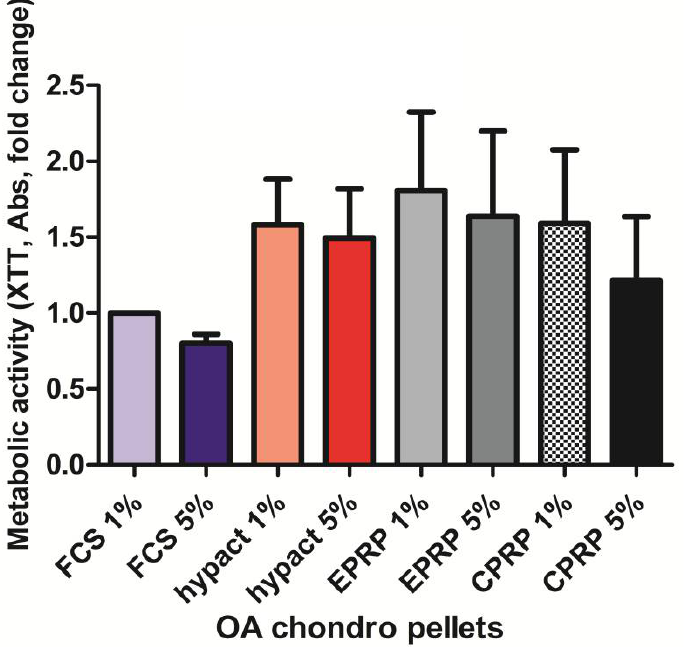
Figure 1. Metabolic activity of OA chondrocytes in 3D pellet culture, n = 5 (CPRP = citrate platelet-rich plasma, EPRP = EDTA platelet-rich plasma, FCS = fetal calf serum, hypACT = hyperacute serum, Results are expressed as the mean ± SD).